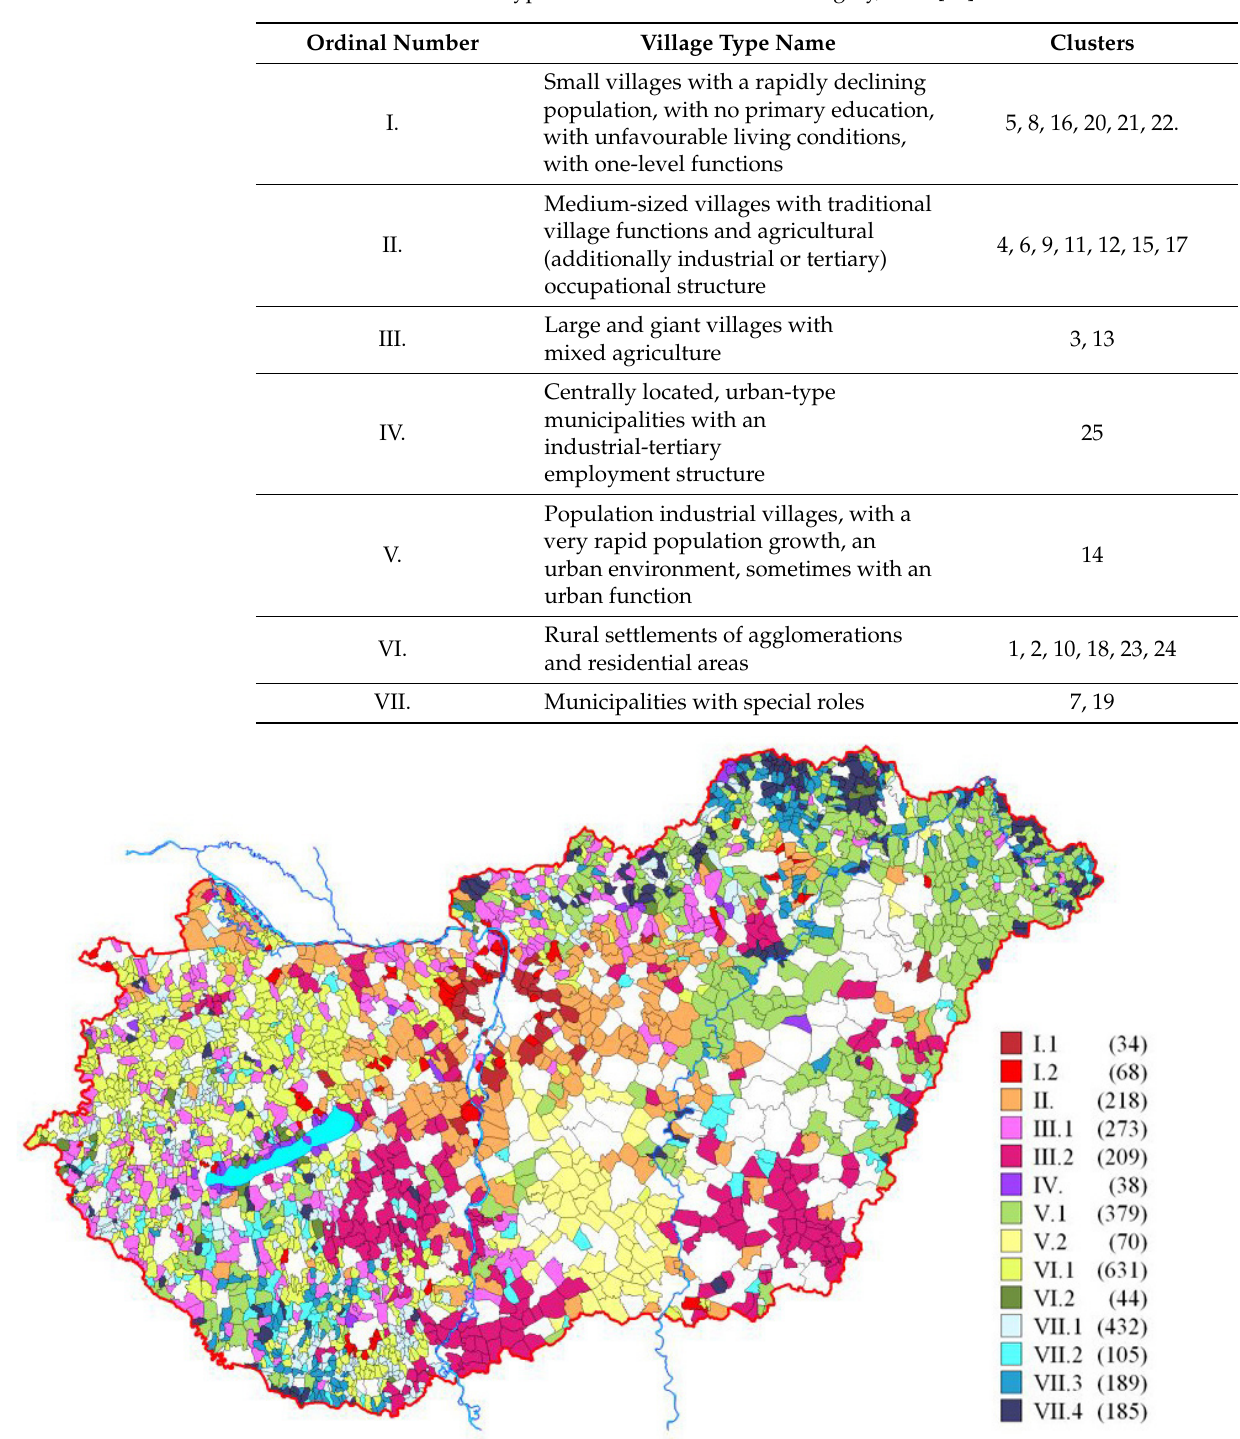
Table 1. The name of the types of rural settlements in Hungary, 1982 [64].